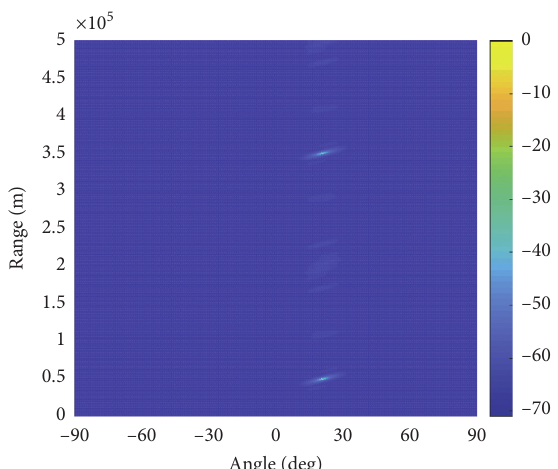
Figure 4: MUSIC spectrum with Δ f